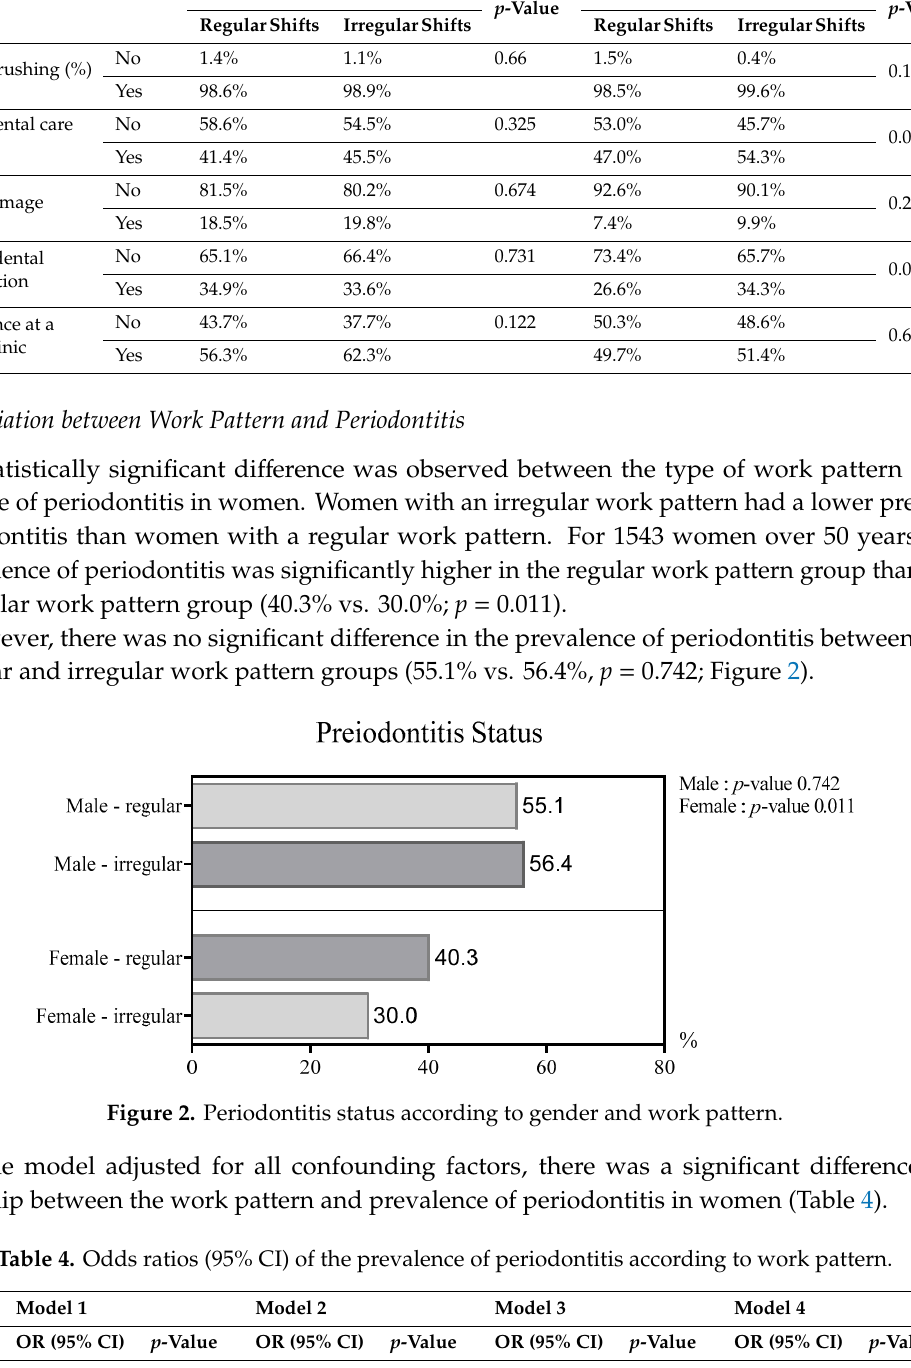
Table 3. Dental health care behaviors according to gender and work pattern.